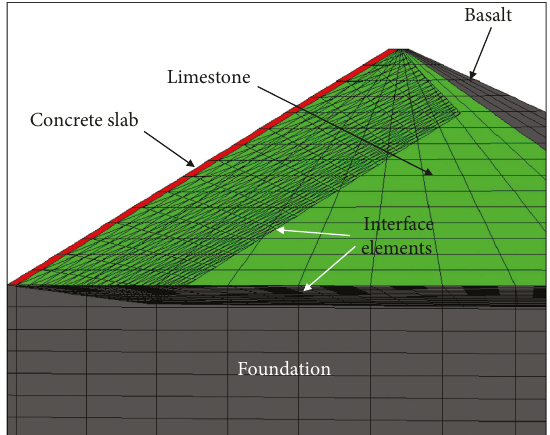
Figure 5: Interface conditions between the dam body-foundation and dam body-concrete slab of the Ilısu